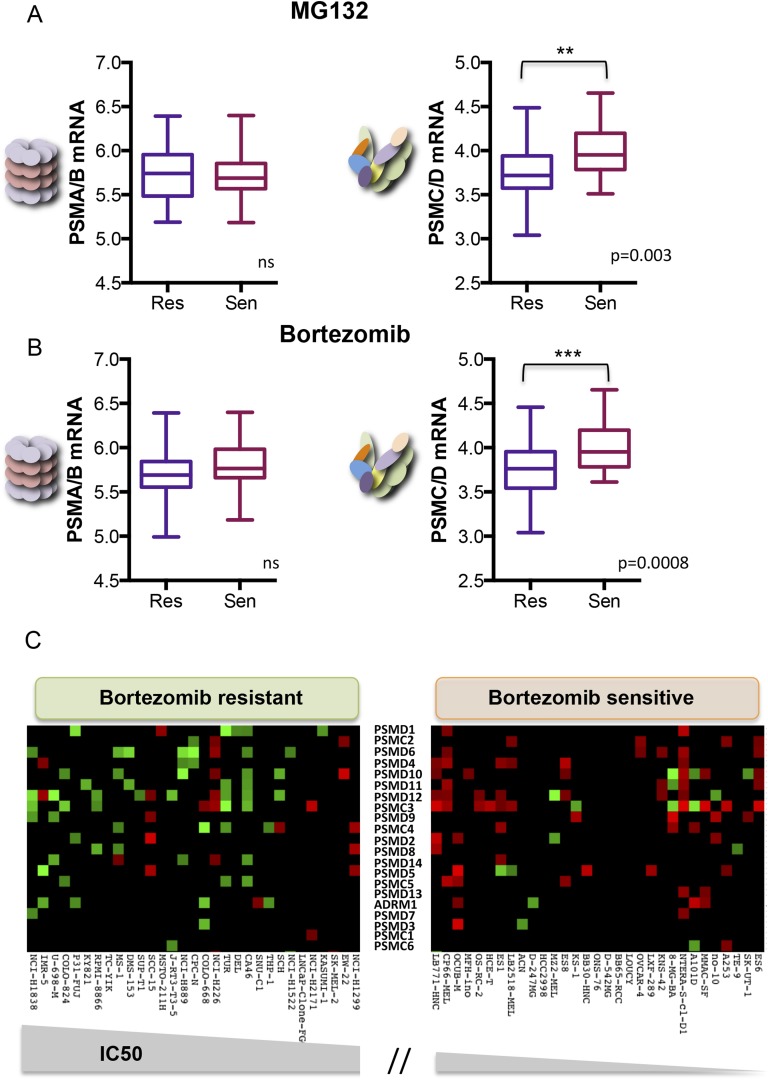
Reduced expression of 19S subunits correlates with resistance to proteasome inhibitors.(A, B) Analysis of expression data from 315 cell lines in the Genomics of Drug Sensitivity in Cancer (GDSC) database (Garnett et al., 2012). The levels of 20S proteasome subunit (PSMAs and PSMBs) gene expression (A and B left panels) and 19S subunit (PSMCs and PSMDs) gene expression (A and B right panels) were analyzed in the cell lines that are the 10% most sensitive or the 10% most resistant to either MG132 (A) or bortezomib (B). (C) The relative expression level of each 19S complex subunit was analyzed in the bortezomib resistant and sensitive groups. Expression levels with deviation of more than twofold from the average were color-coded (red-up, green-down). The p-values were obtained by conducting a two-tailed unpaired t-test. **p < 0.01, ***p < 0.001.